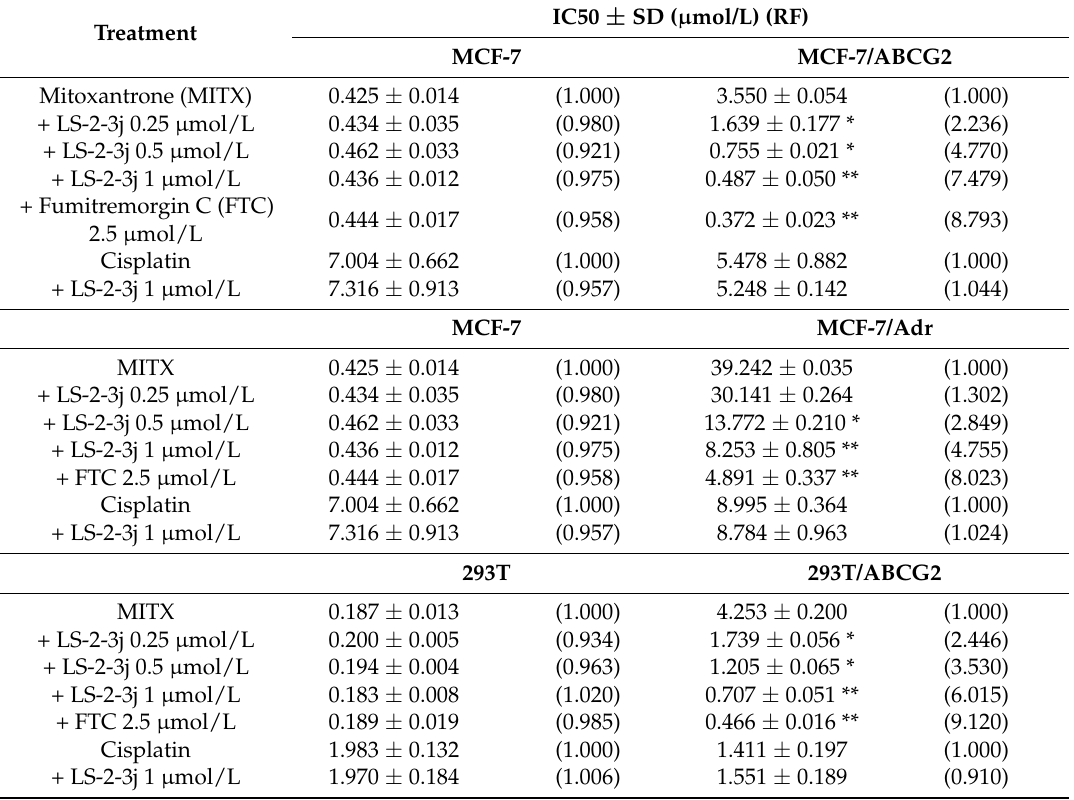
Table 2. LS-2-3j reverses ABCG2-mediated drug resistance in ABCG2-overexpressing cell